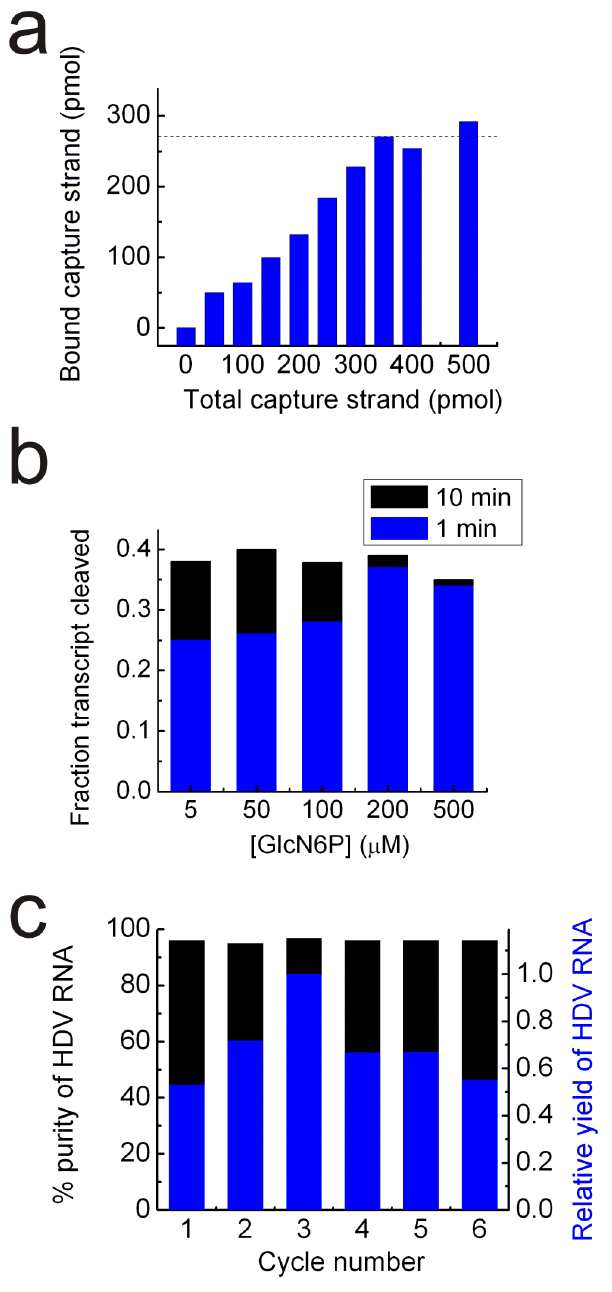
Figure 2. Optimization of important protocol parameters using the transcript containing HDV ribozyme, glmS ribozyme, and binding sequence. ( a ) Titration of 100 m l completed transcription reaction with ssDNA capture strand as analyzed by electrophoretic mobility shift assay (EMSA). The dotted line indicates where we find the amount of RNA:ssDNA hybrid to level off. ( b ) Characterization of glmS ribozyme self-cleavage kinetics. Aliquots of cleavage reaction mix at varying GlcN6P concentrations were taken over a range of times and analyzed by denaturing PAGE. Only the 1 and 10 min time points are shown. ( c ) Streptavidin-coated magnetic beads do not deteriorate over multiple cycles of use. The percent purity of HDV ribozyme as judged by denaturing PAGE analysis is plotted on the left axis, whereas the relative yield of HDV ribozyme (normalized to cycle 3) is plotted on the right